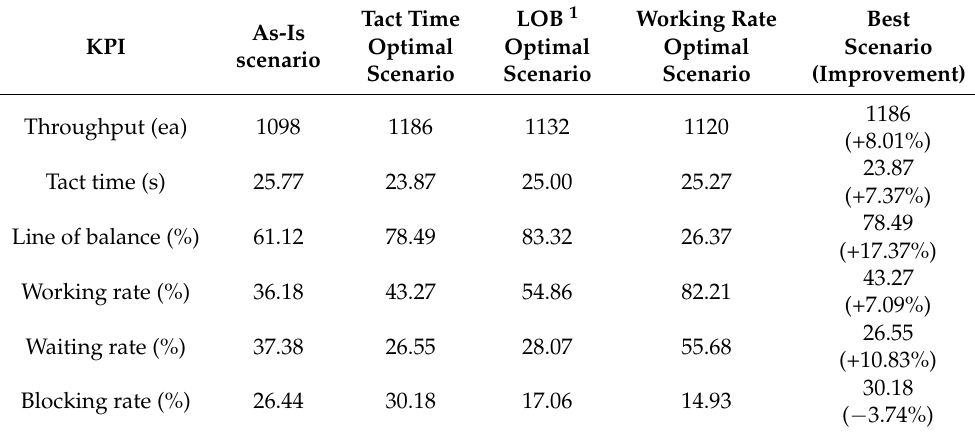
Table 4. Results of Experiment 1.